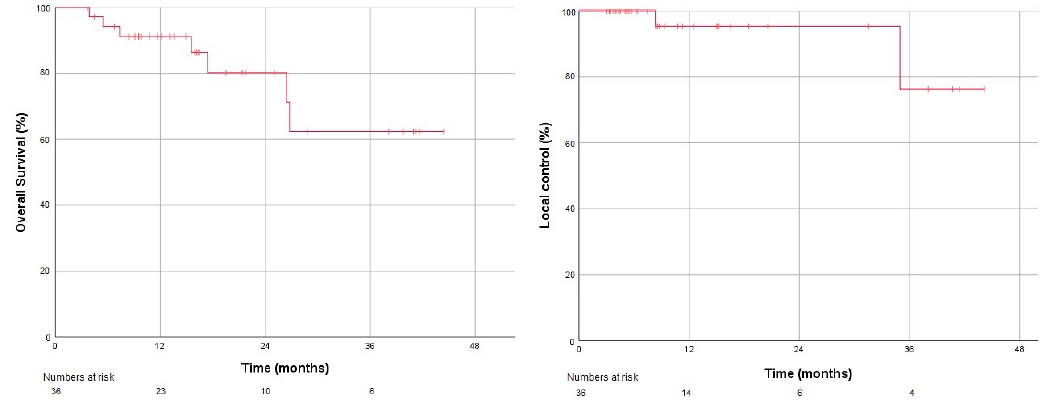
Figure 3. Kaplan-Meier plots for overall survival (left) and local control (right).